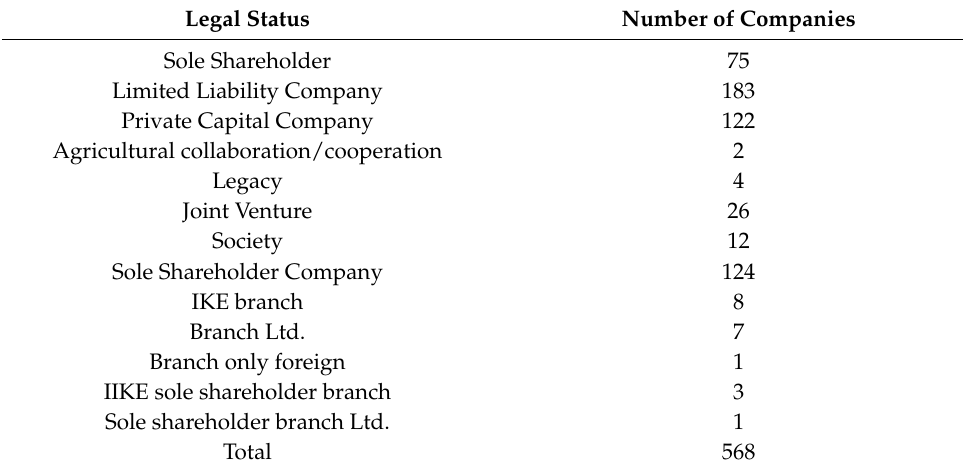
Table 2. Business categories